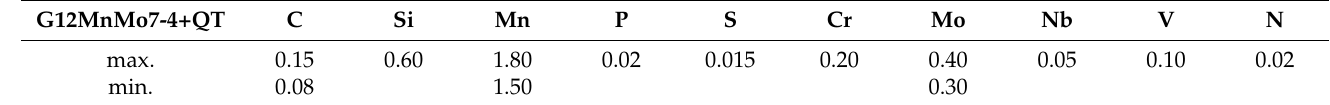
Table 1. Chemical composition in weight percent of the investigated cast steel